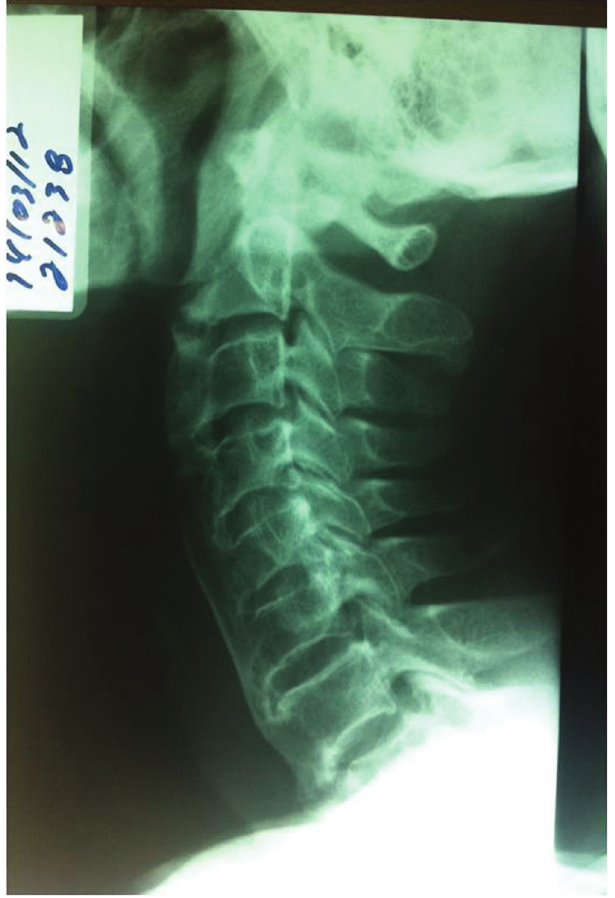
Figure 4 Magnetic resonance images of the cervical spine in T1 showing calcification of the anterior longitudinal ligament, with no involvement of nervous